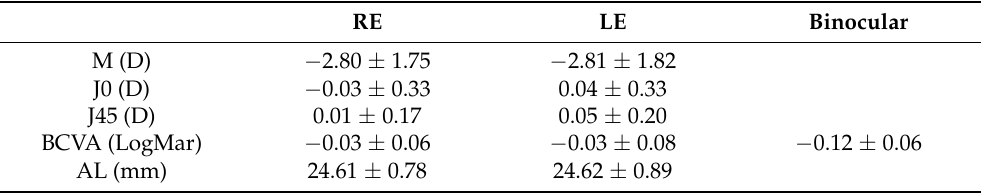
Table 1. Characteristics of the participants in terms of refractive error, visual acuity, and axial length. RE: right eye; LE: left eye; M: spherical equivalent; J0: astigmatic component in the horizontal meridian; J45: oblique astigmatic component; BCVA: best corrected visual acuity; AL: axial